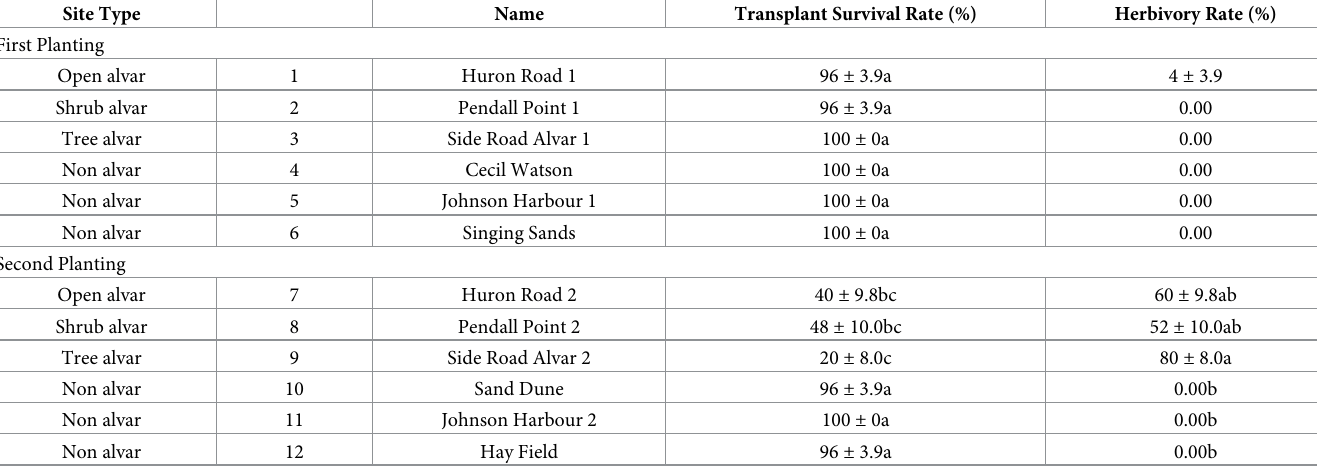
Table 2. Survival rates and herbivory rates recorded in October 2017 of micropropagated plants reintroduced in the twelve sites at Bruce Peninsula National Park, Tobermory, Ontario. The first planting in June occurred on sites 1 to 6 and the second planting in July occurred on sites 7 to 12. Twenty-five plants were randomly assigned to plots within an area of 20 m 2 on each site. Data represents mean ± standard error from 25 plants per site. Means followed by different letters in columns are sig- nificantly different according to Tukey’s HSD test ( P -value < 0.05).